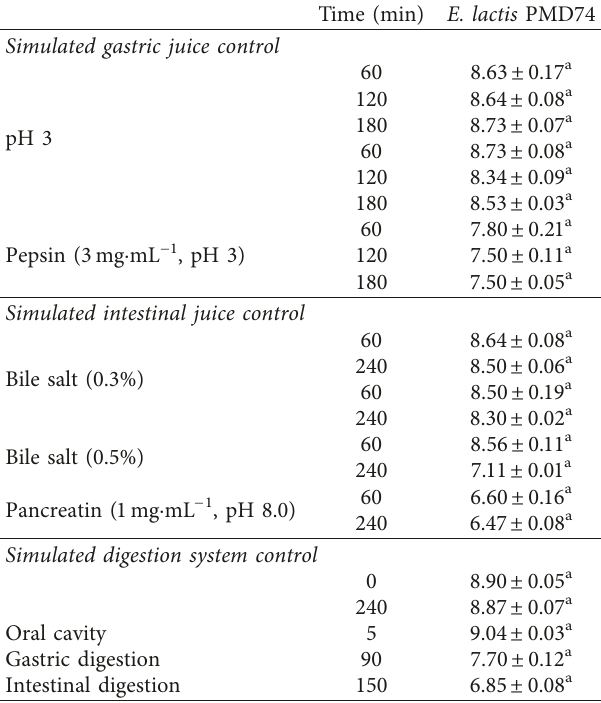
Table 4: Survival of E. lactis PMD74 strain in the simulated gastric and intestinal juices and digestion system (log CFU · mL − 1 ).